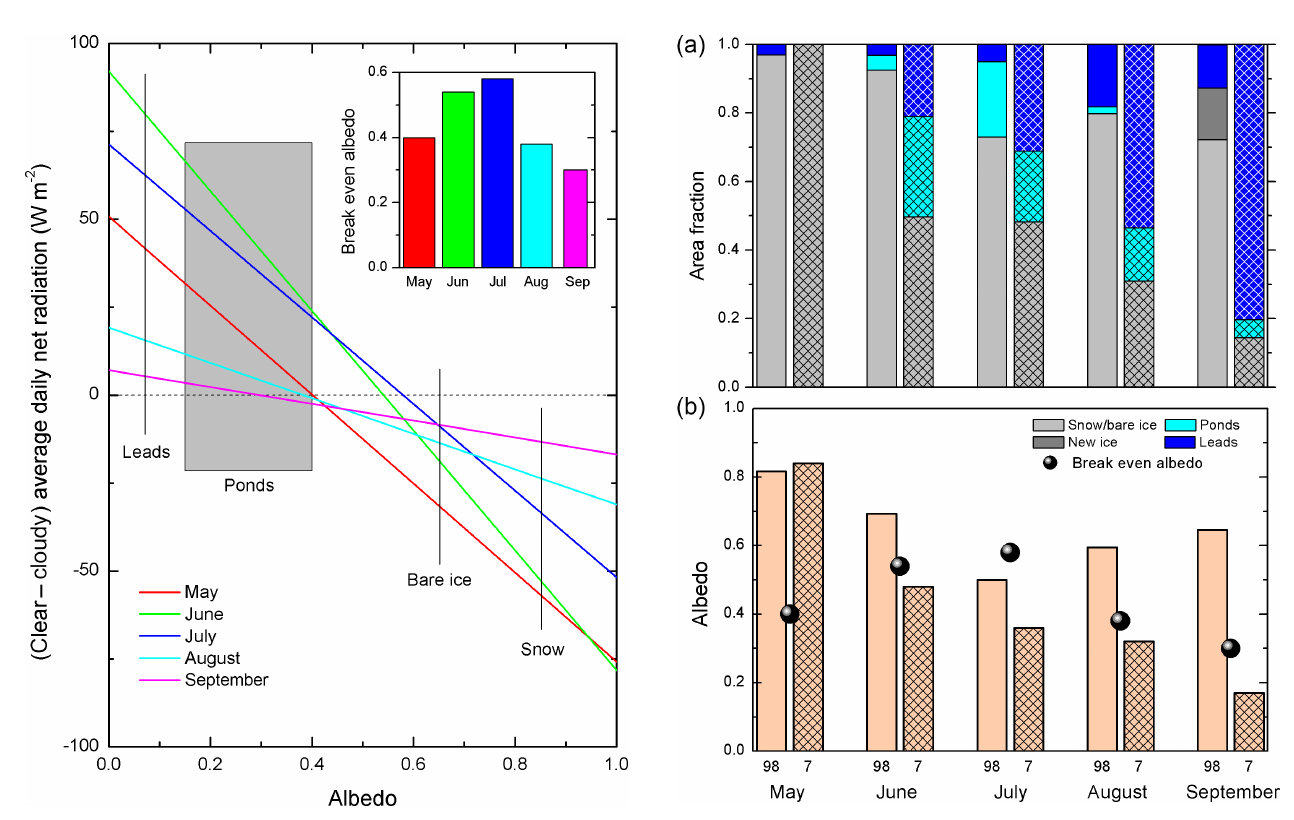
Figure 3. Sunny minus cloudy average daily net radiation as a func- tion of albedo. The albedos of leads, ponds, bare ice, and snow are plotted for reference. The insert shows the break-even albedo for each monthly sunny–cloudy pair.